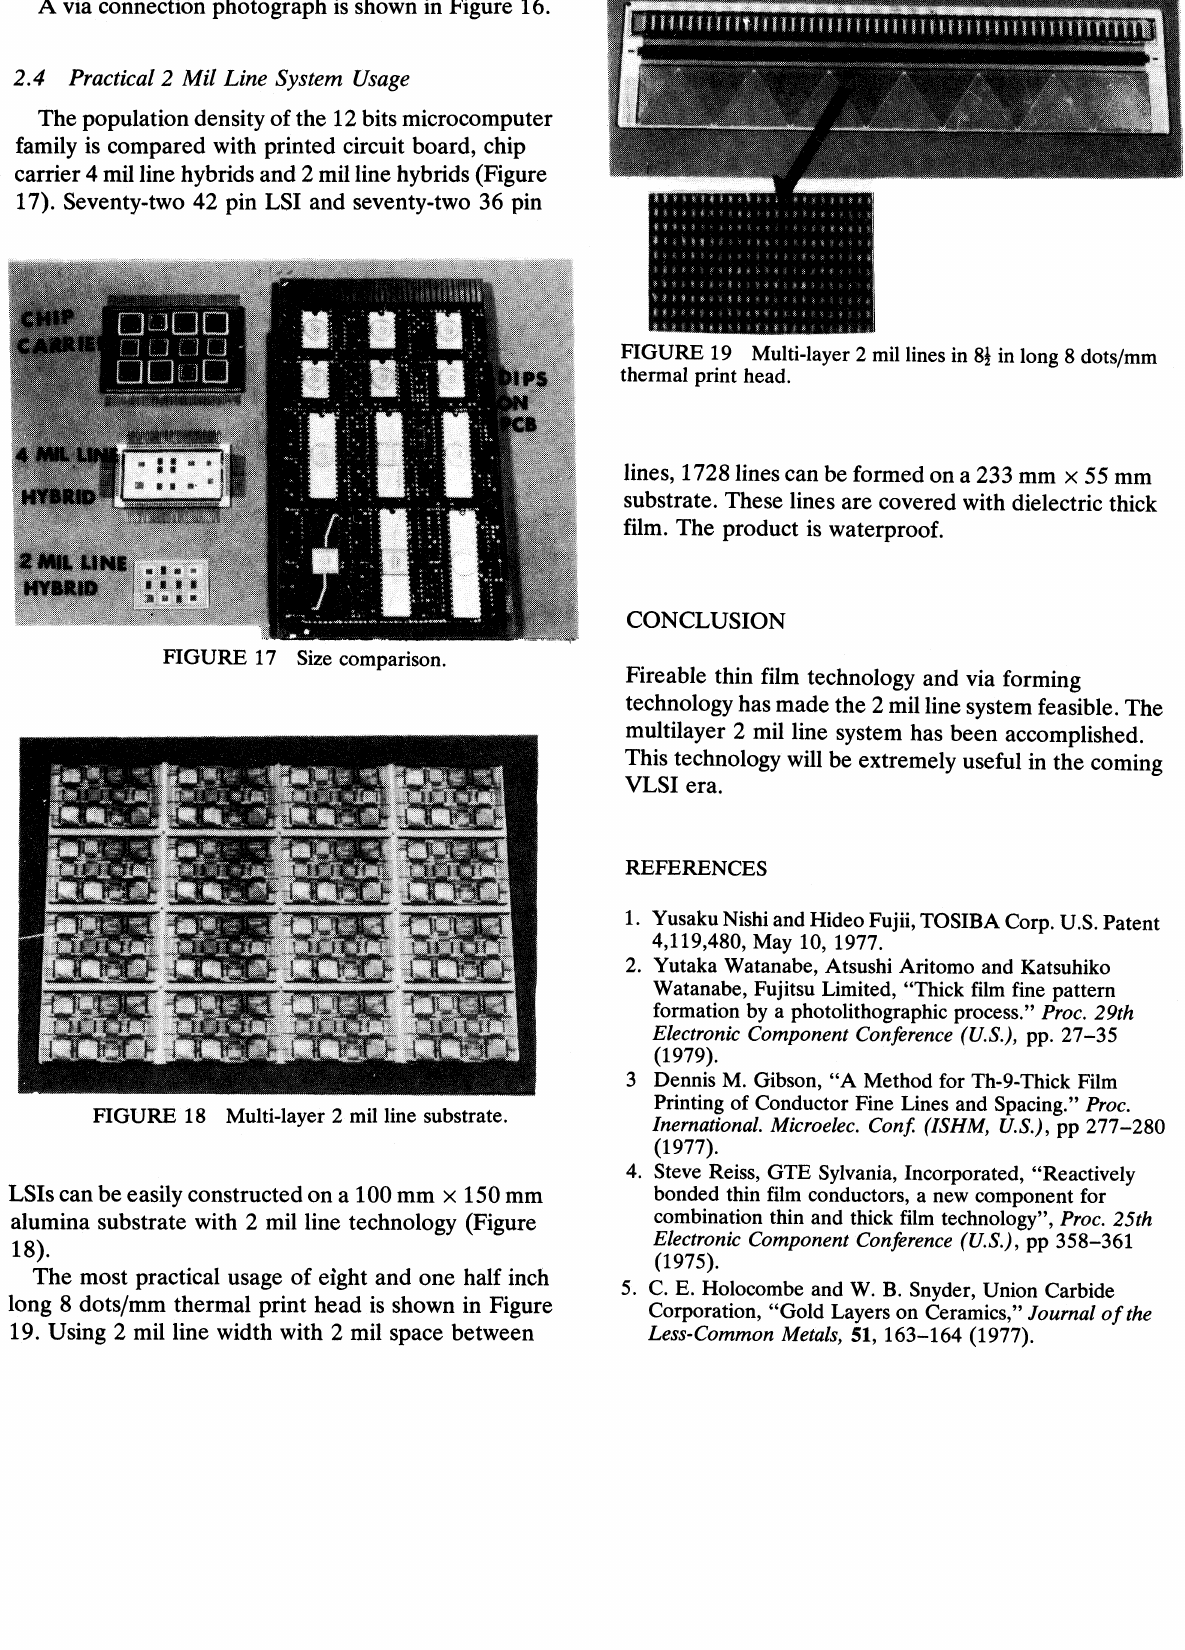
FIGURE 19 Multi-layer 2 mil lines in 81/2 in long 8 dots/mm thermal print head. lines, 1728 lines can be formed on a 233 mm 55 mm substrate. These lines are covered with dielectric thick film. The product is waterproof.